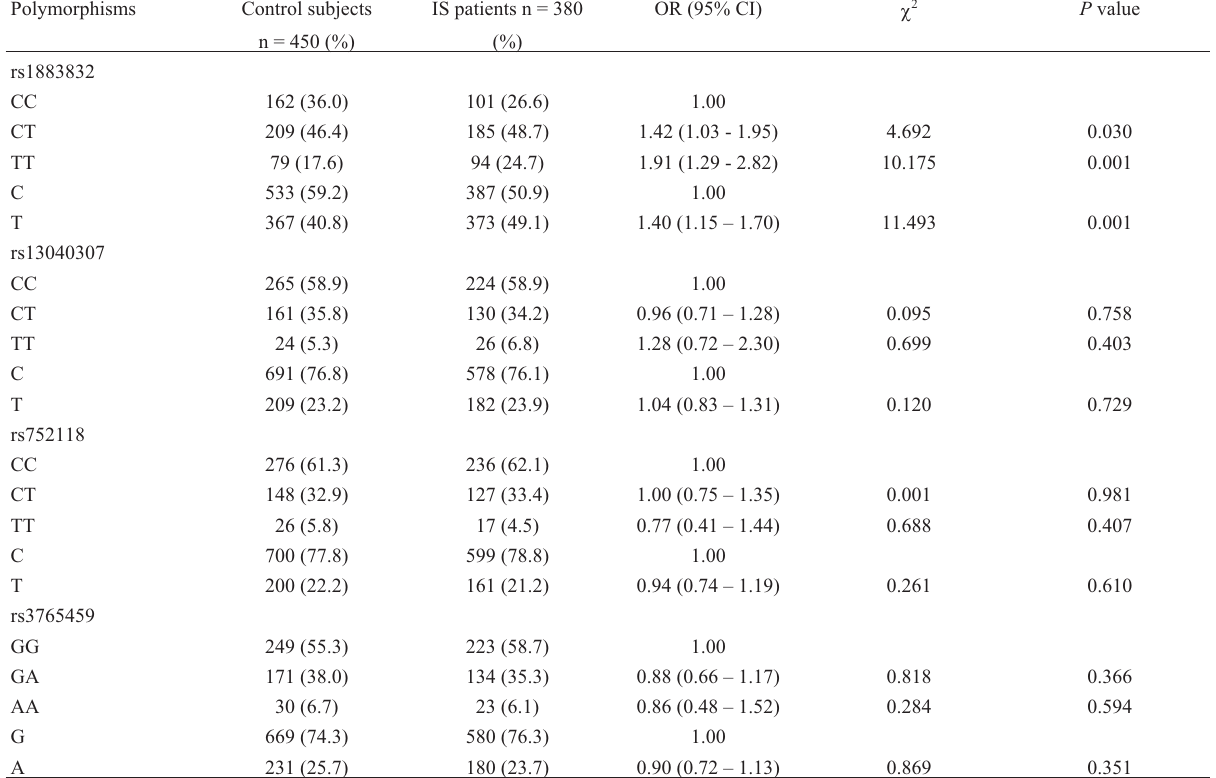
Table2 -DistributionofthegenotypeandallelefrequenciesfourpolymorphismsoftheCD40geneinischemicstroke(IS)patientsandcontrolsubjects.